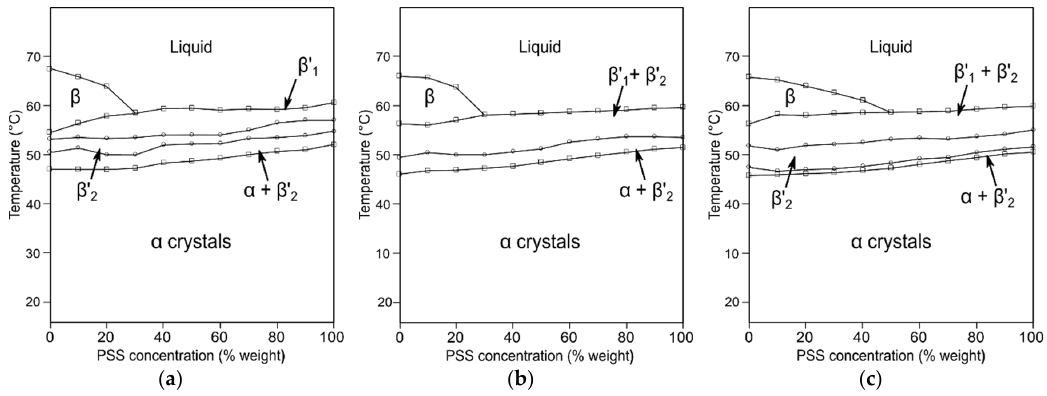
Figure 4. Kinetic phase diagrams of PPP / PSS system obtained under di ff erent kinetic conditions. ( a ) Cooling at 10 ◦ C · min − 1 and heating at 5 ◦ C · min − 1 ; ( b ) cooling at 1 ◦ C · min − 1 and heating at 5 ◦ C · min − 1 ; and, ( c ) cooling and heating at 1 ◦ C · min − 1 . Adapted with permission from [107], © 2018